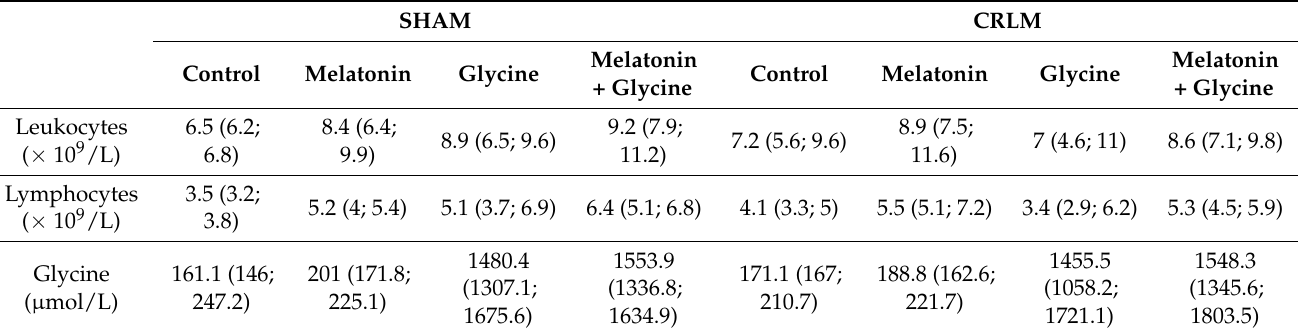
Table 1. Detailed data about leukocytes and lymphocytes count and glycine concentration in serum at the end of the study in study